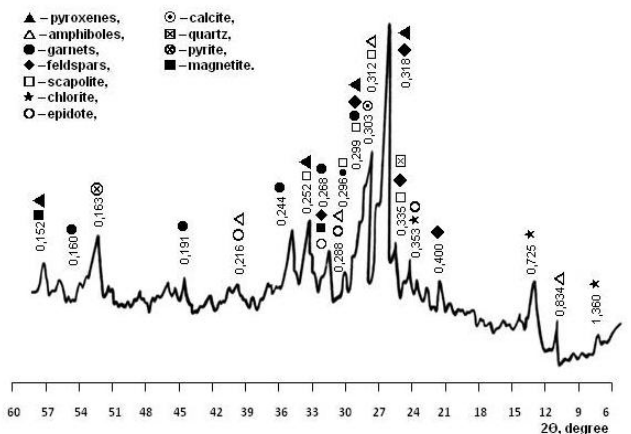
Figure 2. XRD pattern of WMS.